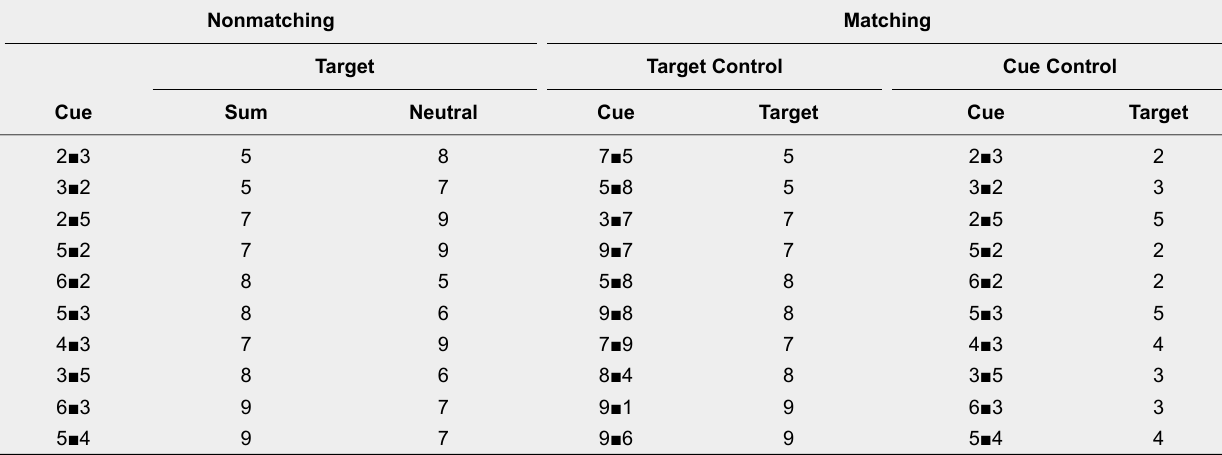
Table 2 Digit Triplets for Matching and Nonmatching Conditions in the Number Matching Task MatchingNonmatching